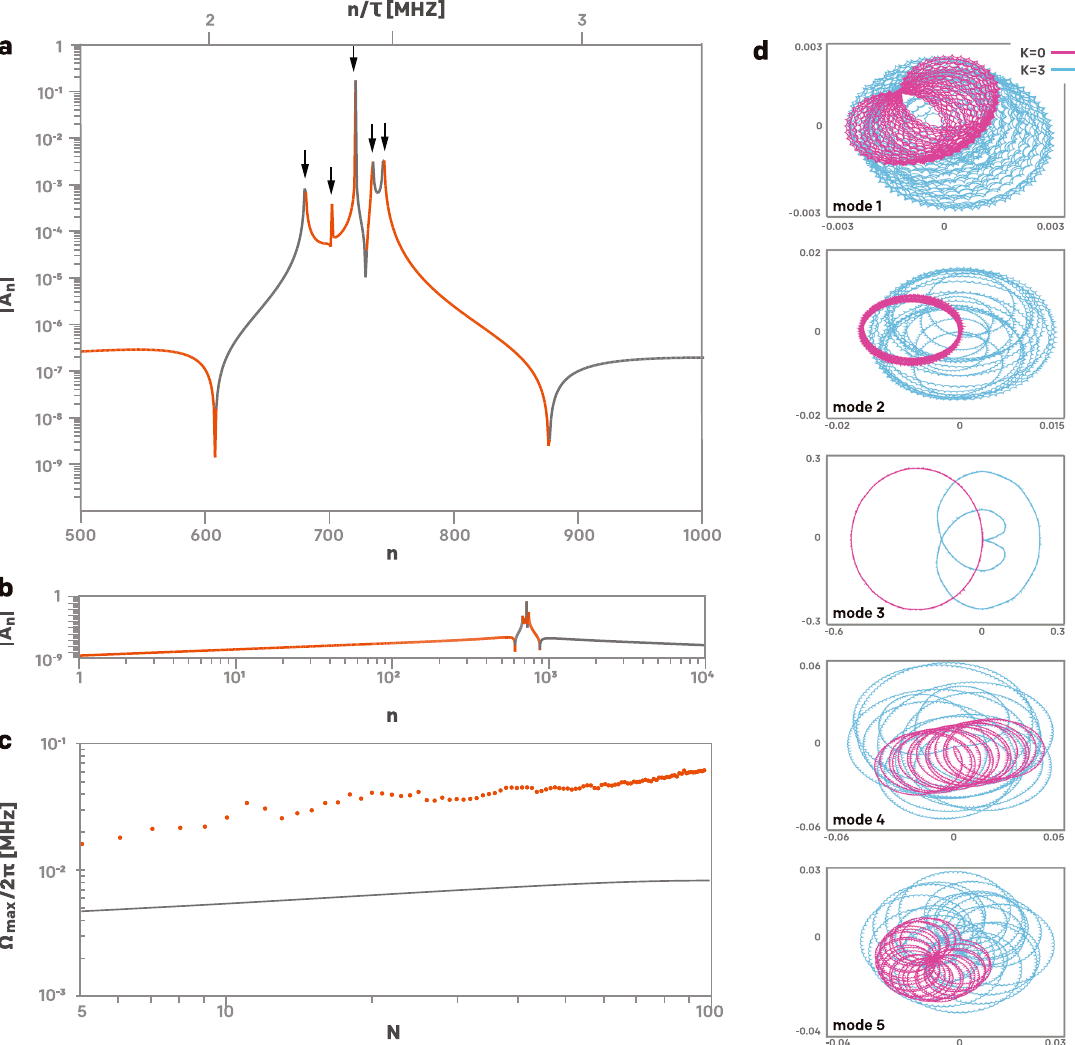
P A n sin ð 2 π nt = τ Þ , n n are color-coded,